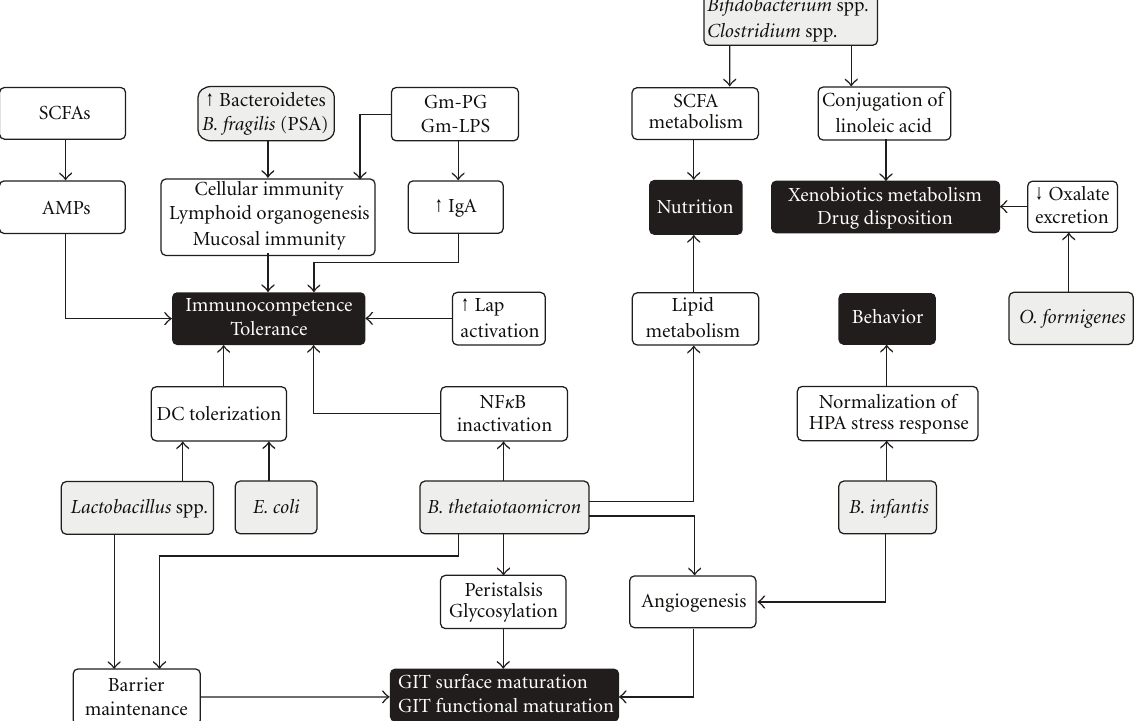
Figure 2: The complex web of gut microbiota contributions to host physiology. Di ff erent gut microflora components can a ff ect many aspects of normal host development, while the microbiota as a whole often exhibits functional redundancy. Members of the microbiota are shown in gray, with their components or products of their metabolism. Their e ff ects on the host at the cellular or organ level are shown in white. Black ellipses represent the a ff ected host phenotypes. Only some examples of microbial members/components contributing to any given phenotype are shown. AMP: antimicrobial peptides; DC: dendritic cells; Gm − : gram negative; HPA: hypothalamus-pituitary adrenal; Iap: intestinal alkaline phosphatase; PG: peptidoglycan; PSA: polysaccharide A. Extracted from: Phys Rev 2010 Sekirov et